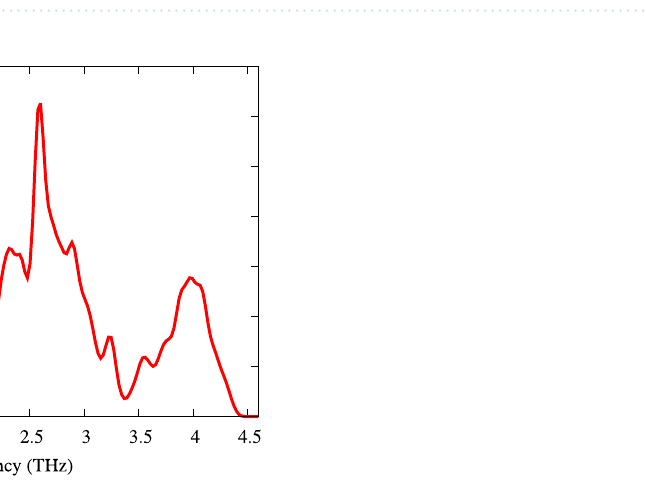
Figure 15. Phonon bandstructure and partial density of states of CeIn 3 at zero pressure. The solid (dashed) line denote the Ce (In) PDOS.